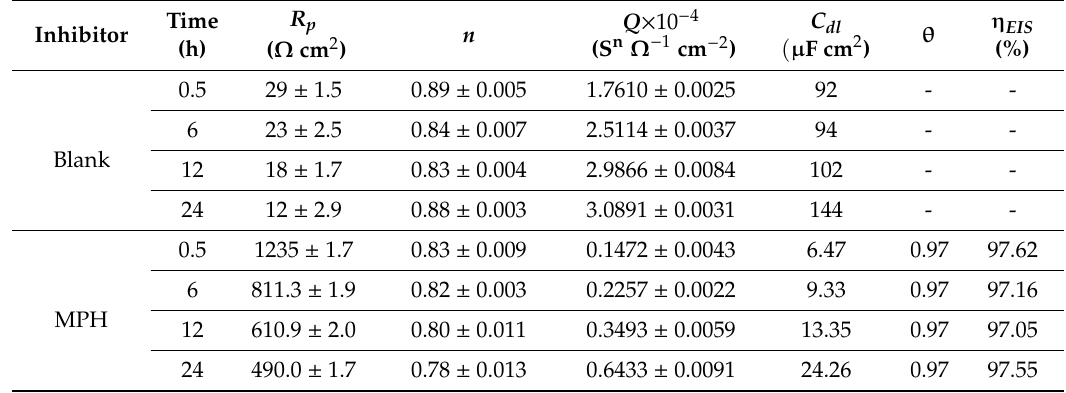
Table 8. Electrochemical impedance spectroscopy parameters for mild steel in the absence and presence of MPH vs. immersion